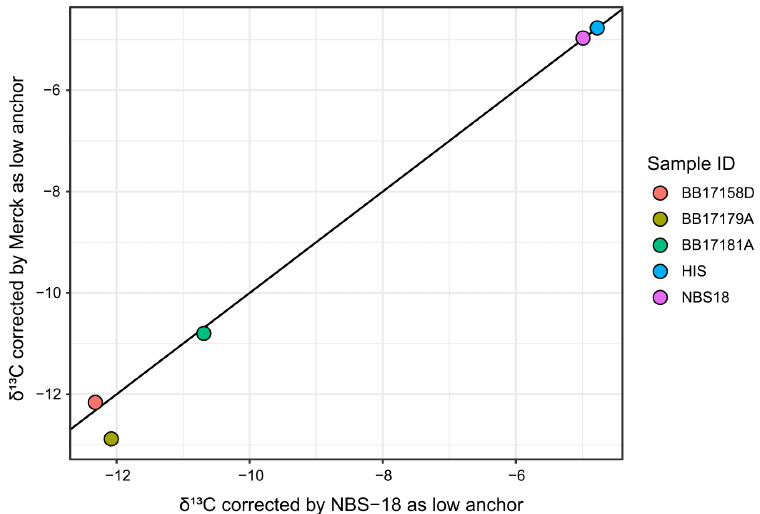
Figure C2. δ 13 C values for standards and a subset of samples that were run in a session that used NBS-18 as a low δ 13 C anchor, as well as in a session that used MERCK as the low δ 13 C anchor. Most fall on the 1 : 1 line (black line), and the two samples that fall off the line show no systematic offset, suggesting that the difference in those values is not due to the difference in anchor standard.